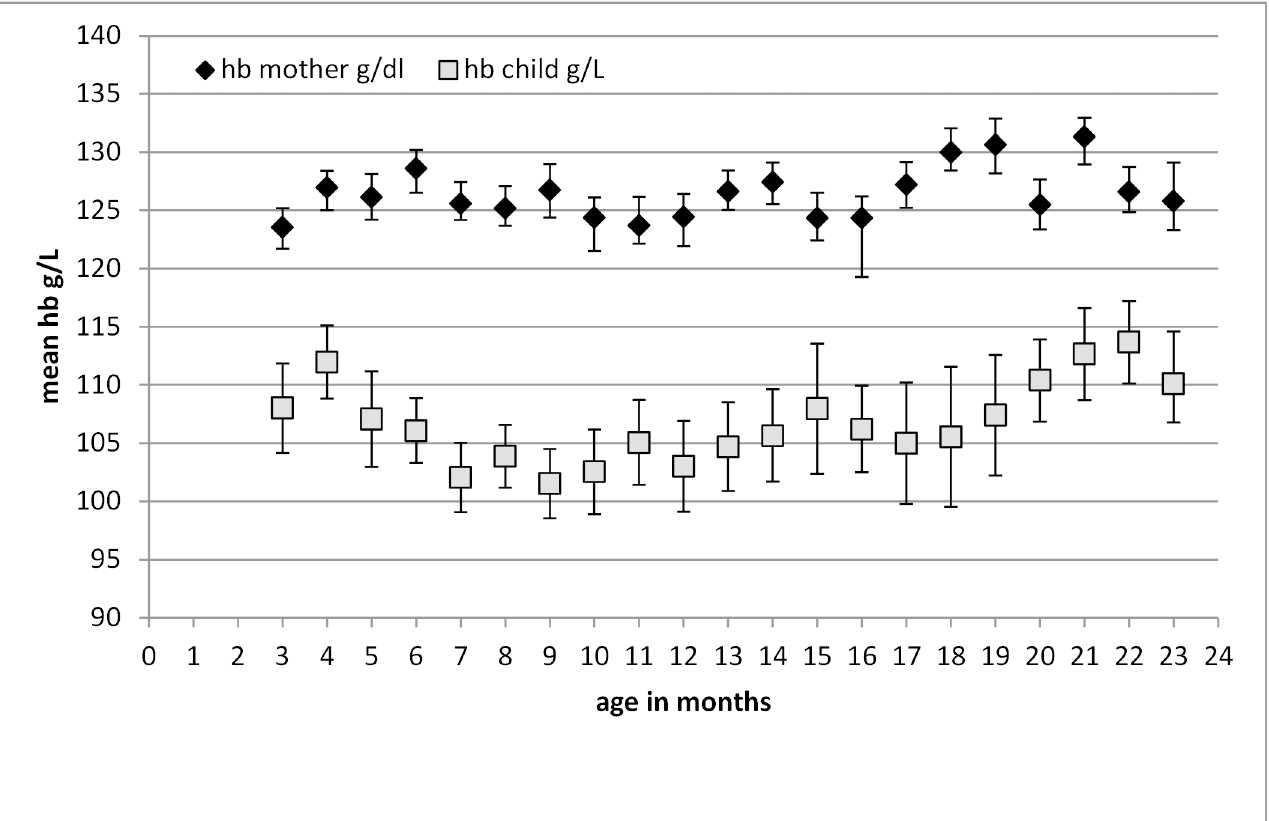
Fig 1. Mean child hemoglobin concentrations ( ± SD) by age groups in months with respective maternal hemoglobin concentrations. 3 < 4 mo: N = 38, 4 < 5 mo: N = 45, 5 < 6 mo: N = 39, 6 < 7 mo: N = 52, 7 < 8 mo: N = 55, 8 < 9 mo: N = 55, 9 < 10 mo: N = 56, 10 < 11 mo: N = 57, 11 < 12 mo: N = 55, 12 < 13 mo: N = 60, 13 < 14 mo: N = 53, 14 < 15 mo: N = 44, 15 < 16 mo: N = 28, 16 < 17 mo: N = 46, 17 < 18 mo: N = 32, 18 < 19 mo: N = 29, 19 < 20 mo: N = 25, 20 < 21 mo: N = 37, 21 < 22 mo: N = 42, 22 < 23 mo: N = 40, 23 < 24 mo: N = 33. mo = months.